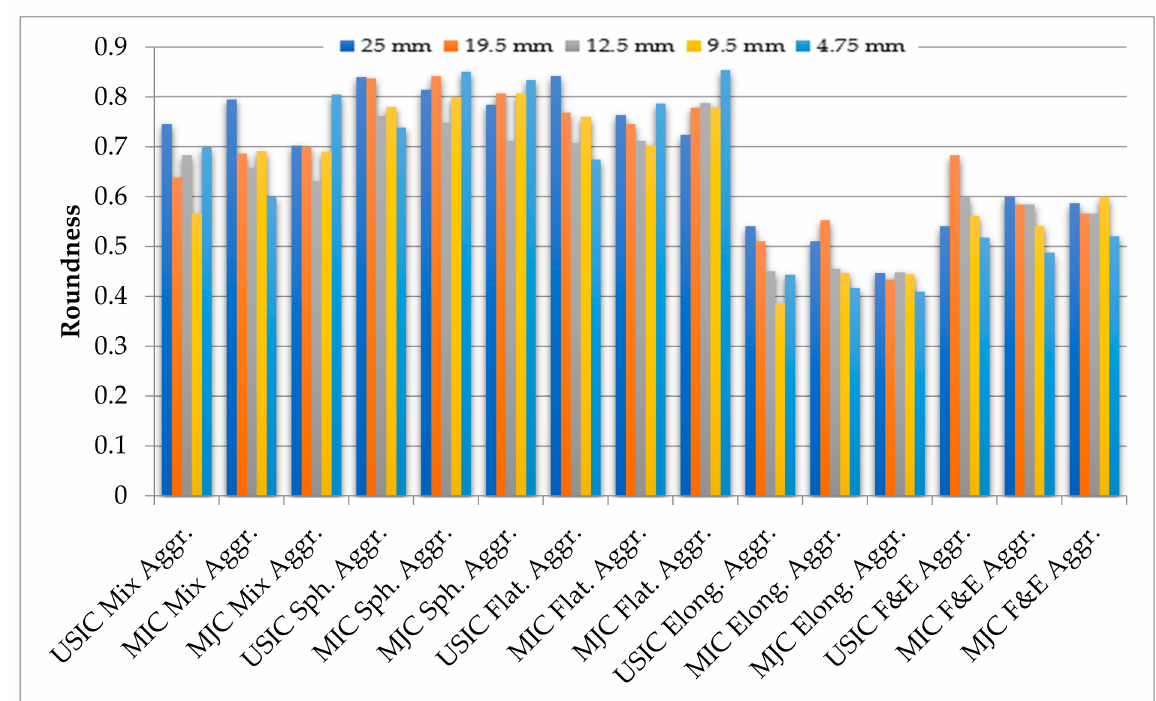
Figure 8. Sphericity of different shapes of aggregates and types of crushers.